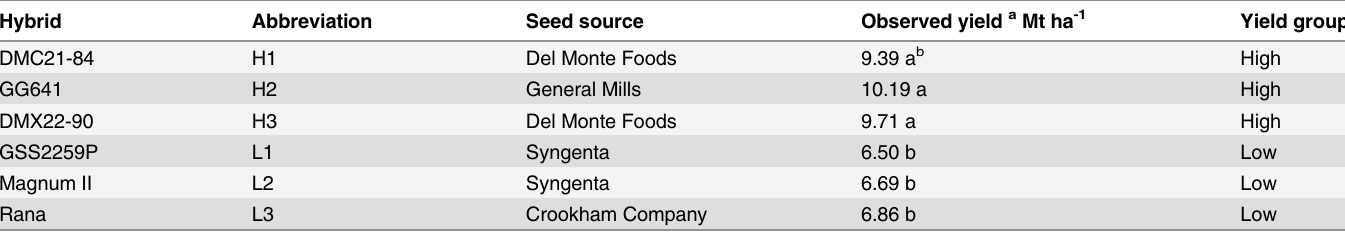
Table 1. Description of six sweet corn hybrids used in the